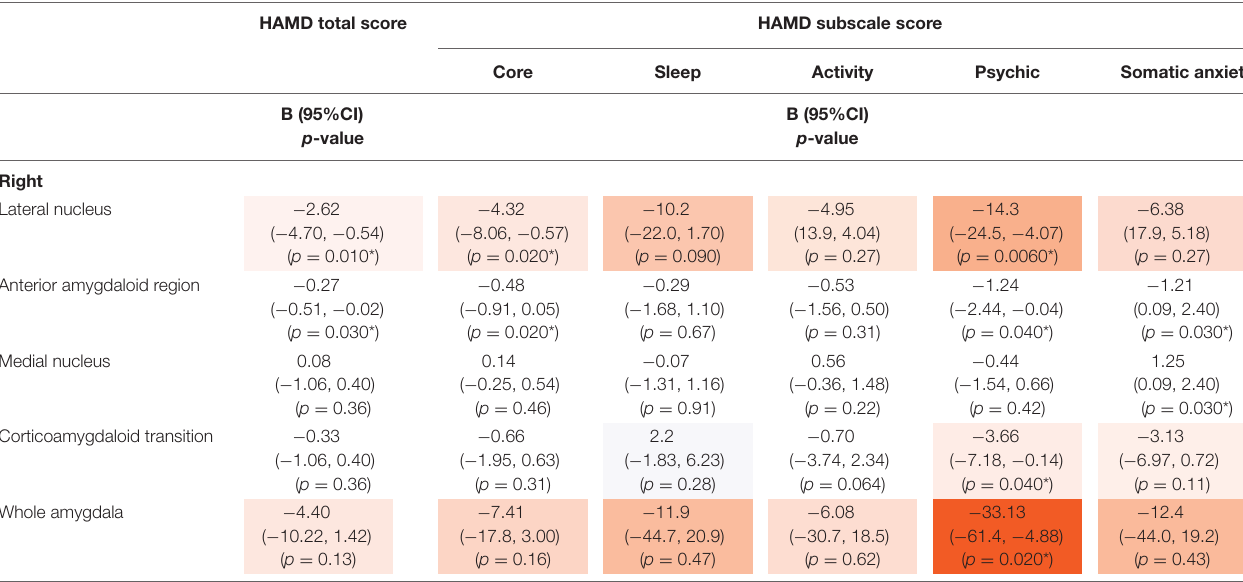
TABLE 3B | The HAMD scores and amygdala subregions (Heat